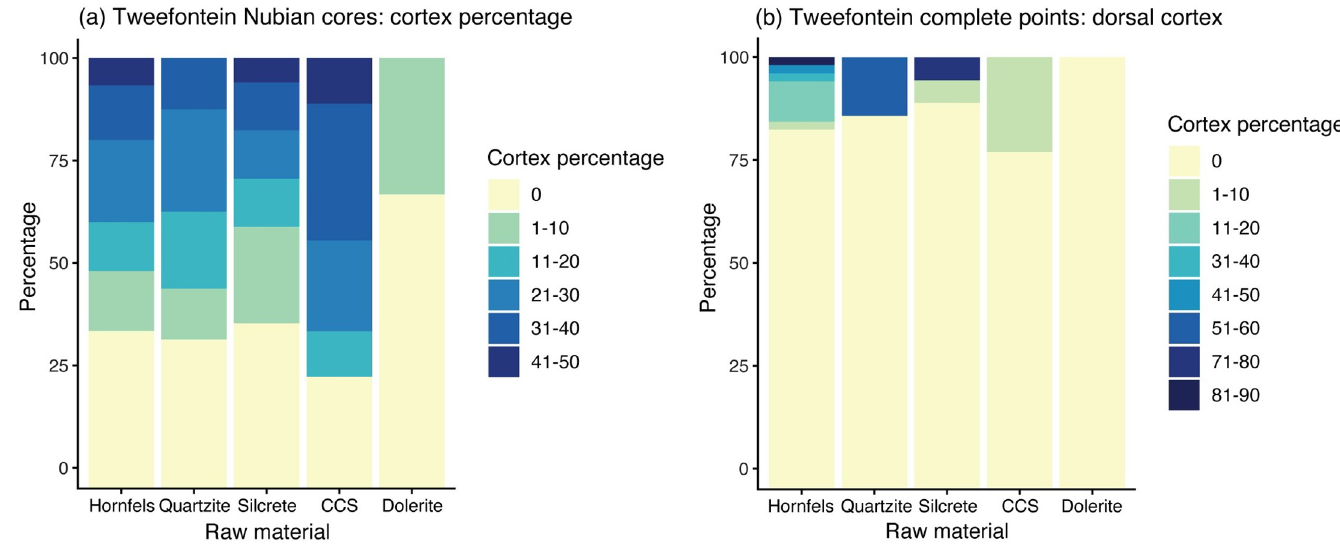
Fig 13. Bar graphs showing artefact cortex percentage. (a) Nubian cores and (b) points.